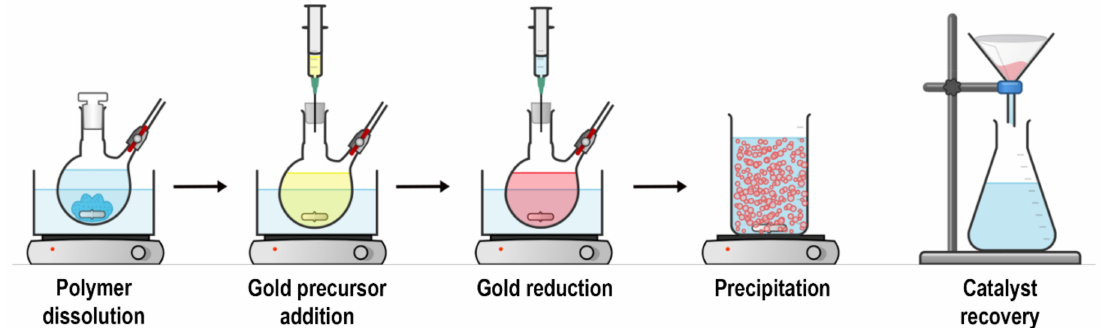
Figure 3. Synthesis of AuNPs supported by sPSB. Adapted with permission from reference [37].